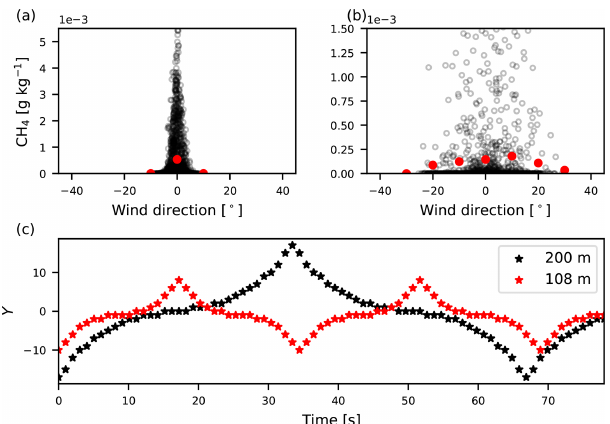
Figure 1. (a) Methane concentration plotted against the wind direc- tion according to the OTM 33A protocol for the case where no me- andering is imposed. (b) Methane concentrations against the wind direction with imposed meandering. Red circles indicate bin aver- ages. Bins of 10 ◦ are used. (c) An example of the sampling pattern used to impose meandering for two distances from the